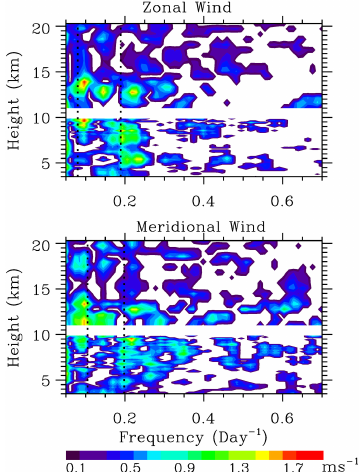
Figure 10. Lomb–Scargle periodogram of the diurnal tidal ampli- tude in April 2012. The maximum spectral magnitudes for the zonal and meridional winds are 1.83 and 1.68ms − 1 , respectively. The spectral peaks for the PW modulation periods (12.92 and 5.29 days in the zonal component, and 8.92 and 5.04 days in the meridional component) are marked by dotted vertical